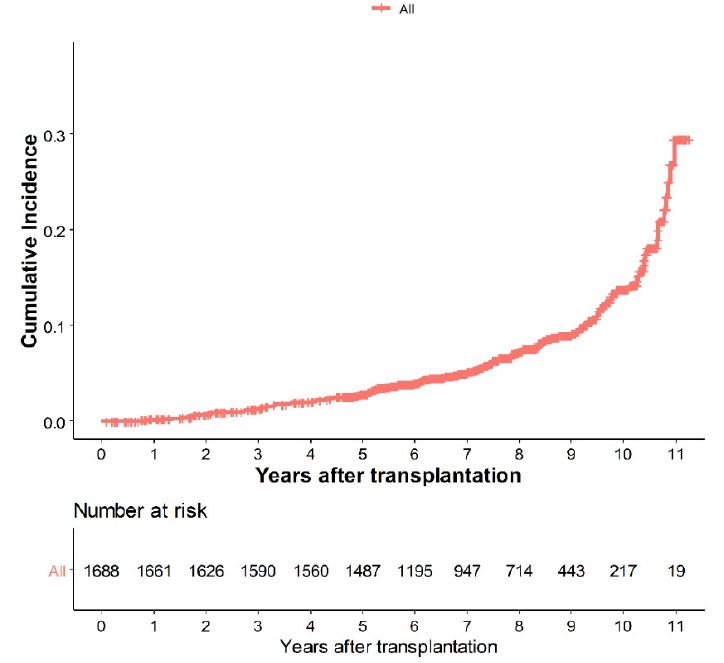
Figure 2. Cumulative incidence of herpes zoster infection after living donor liver transplantation. The incidence at 1, 3, 5, 8, and 10 years was 0.1%, 1.3%, 2.9%, 7.2%, and 13.5%, respectively.